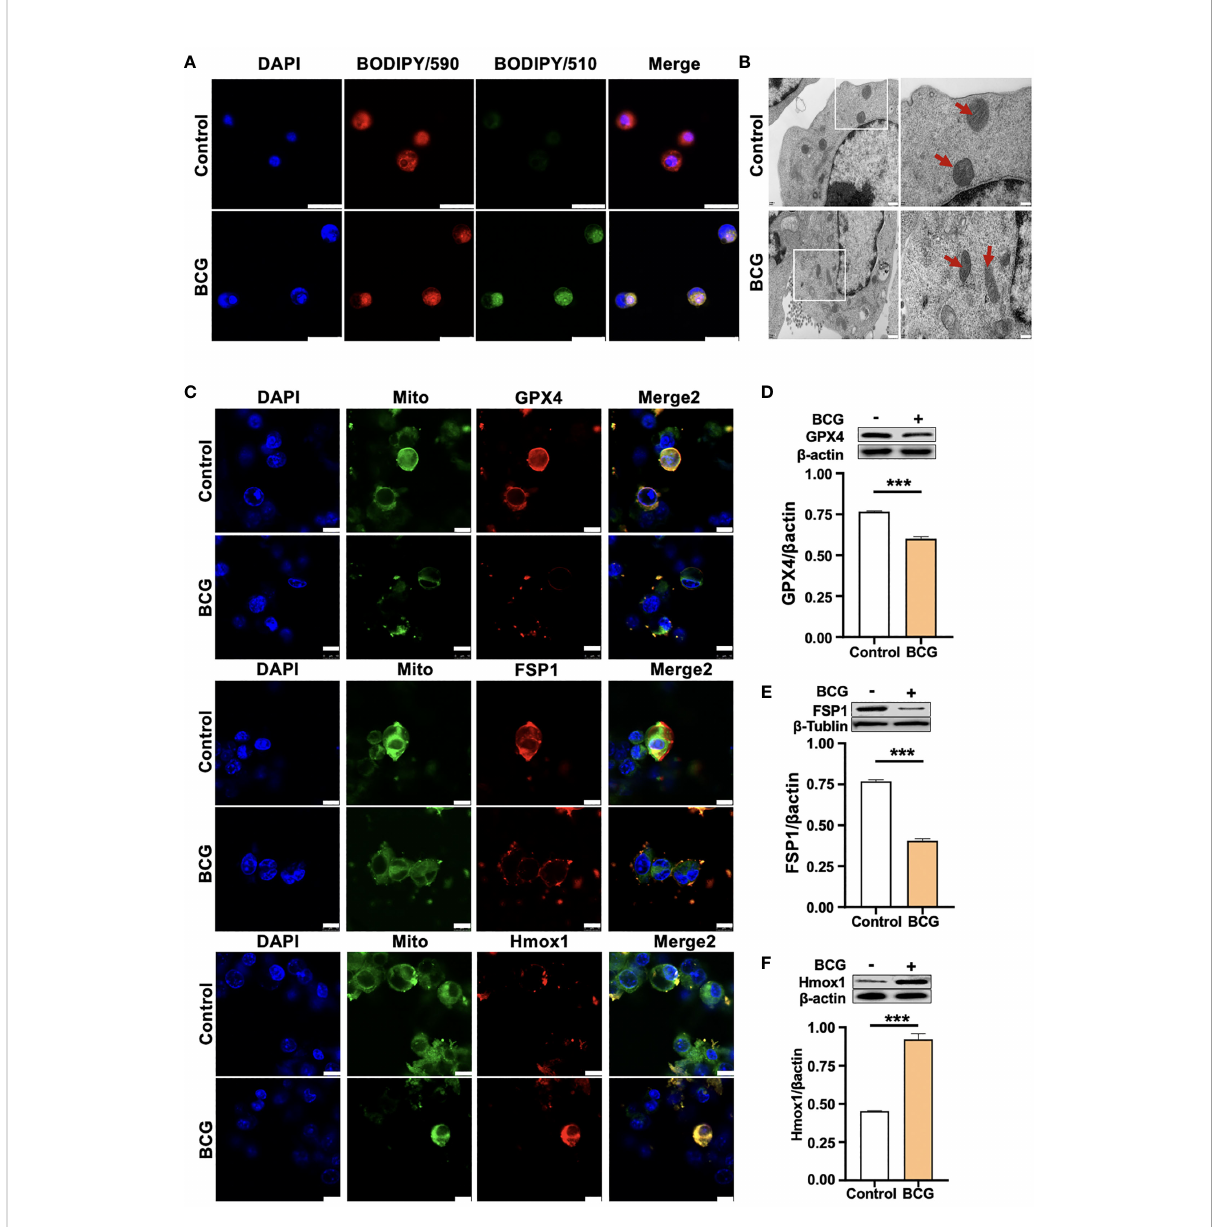
FIGURE 3 HO-1 is involved in the BCG-induced macrophage ferroptosis. (A) Representative images of BODIPY 581/591 C11-labeled lipoxidation of polyunsaturated fatty acids. BCG-infected RAW264.7 cells showed a strong positive lipid peroxidation (Green/510 nm) compared to the uninfected cells. (B) Representative images of transmission electron microscopy showed mitochondrial membrane ridge breaks (arrows) in RAW264.7 macrophages infected by BCG; the right panel shows the enlarged image of the boxed area in its corresponding image in the left panel. (C) Representative immuno fl uorescence images of Gpx4 (top panels), Fsp1 (middle panels), and HO-1 (bottom panels) showed the decrease of anti-ferroptotic markers Gpx4 and Fsp1, but increased pro-ferroptotic marker HO-1 in BCG-infected cells. Cell mitochondria were labeled with CellLight ™ Mitochondria-GFP (green), which were reduced in macrophages following the BCG infection. (D – F) Representative blots and semi-quantitative analysis of Gpx4, Fsp1, and HO-1 proteins of RAW264.7 cells. Statistical analysis of data performed using GraphPad Prism 8.0.1 software and ImageJ 1.52.a. Cell nuclei were counterstained with DAPI. Data obtained from three independent experiments were processed using GraphPad Prism 8.0.1 software and ImageJ 1.52.a. Unpaired t -test was used to analyze the differential changes of two groups. Data are presented as mean ± SD from three independent experiments (*** p < 0.001; n = 3). Bars, 500 nm in the right panel and 200 nm in the left panel of A, 25 m m in B, and 10 m m in